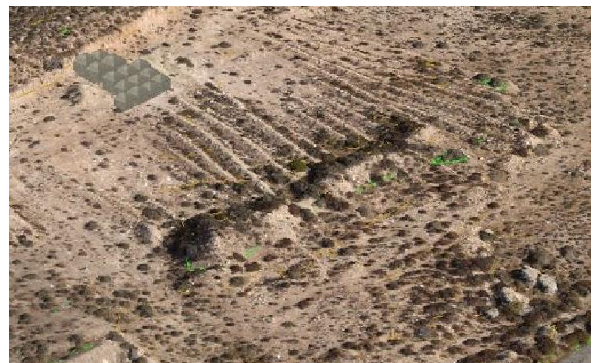
Figure 11. Augmented reality model on the Google Earth